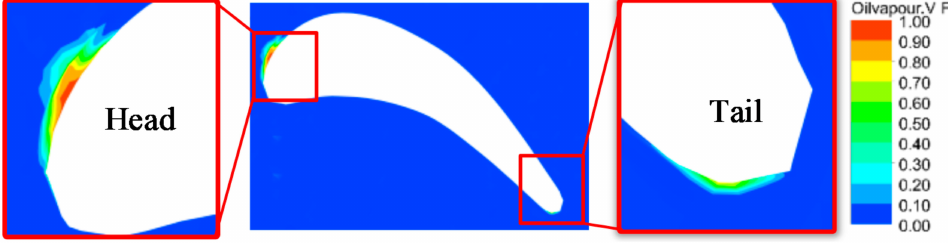
Figure 10. Oil vapor volume fraction distribution near the stator blade of torque converter.